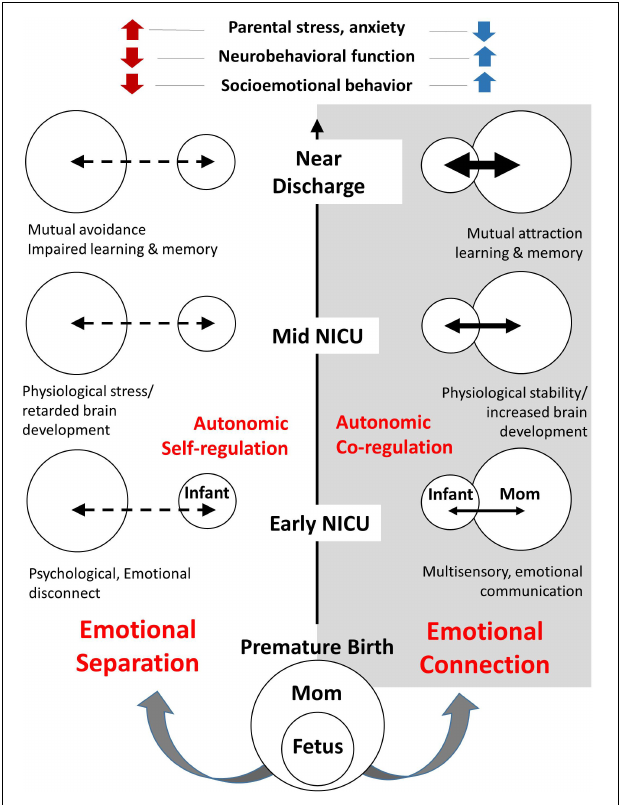
FIGURE 5 | Schema showing the positive effects of facilitating and maintaining emotional connection between mother and infant in the NICU (SC = standard care; FNI = standard care plus Family Nurture